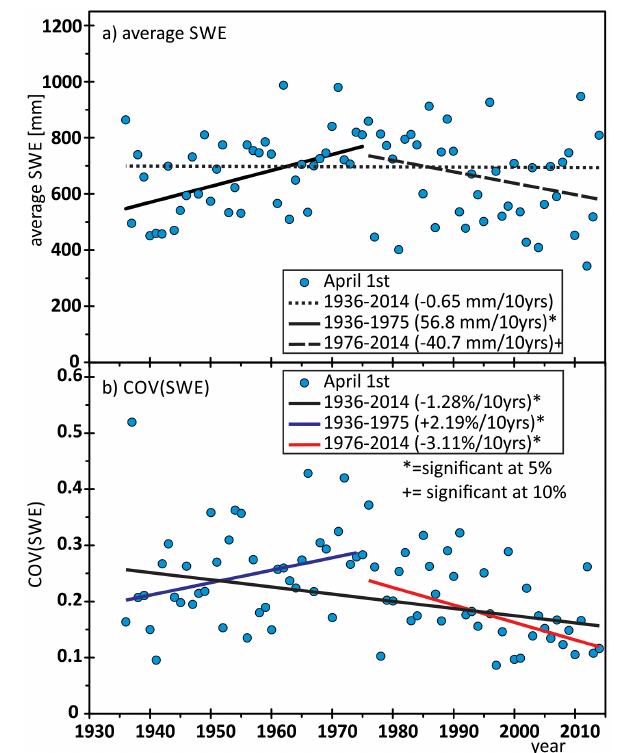
Figure 3. Trends in 1 April SWE at the Cameron Pass snowcourse over the entire period of record (1936–2014) and the two halves (1936–1975, 1976–2014) for (a) average, and (b) coefficient of vari-